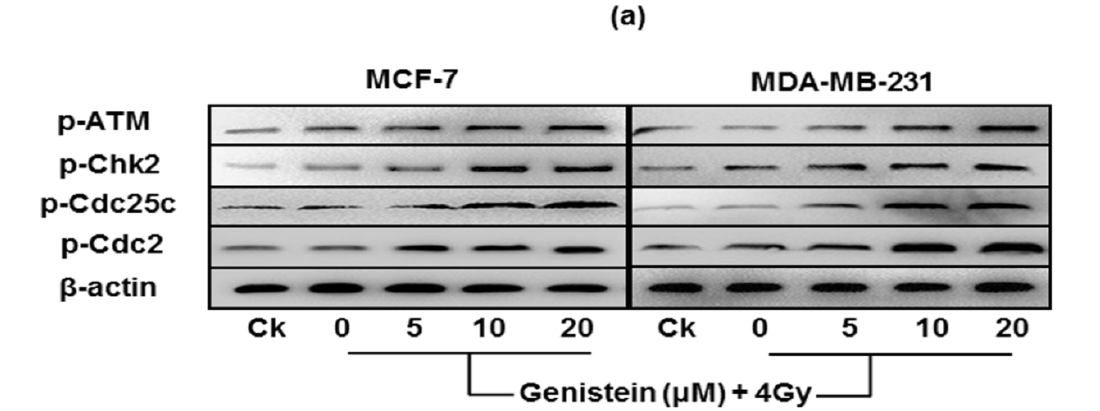
Figure 8. Effect of genistein combined with X-ray irradiation on the expression of G checkpoint proteins in MCF-7 and MDA-MB-231 cells. (a) Representative blots from three independent experiments, where β -actin served as a loading control; (b) Quantative protein expression levels relative to control in MCF-7 cells; (c) Quantative protein expression levels relative to control in MDA-MB-231 cells. All data are presented as means ± SD from three independent experiments. * p < 0.05, ** p < 0.01 versus control group; # p <